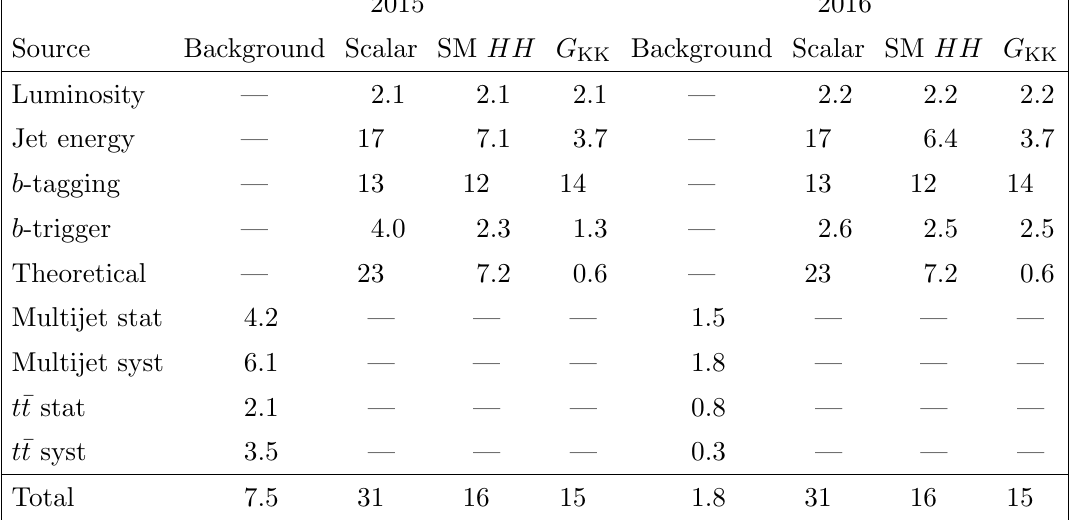
Table 2. Summary of systematic relative uncertainties (expressed in percentage yield) in the total background and signal event yields in the signal region of the resolved analysis. Uncertainties are provided for both the 2015 and 2016 analyses for background, a G KK resonance with k=M Pl = 1 and m ( G KK ) = 800 GeV, a scalar with a mass of 280 GeV and SM non-resonant Higgs boson pair production. The total uncertainties include the e(cid:11)ect of